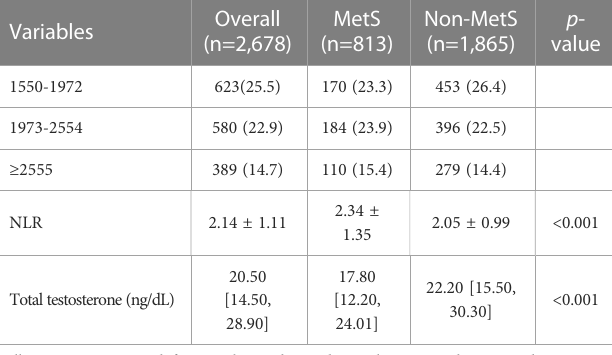
*All estimates accounted for sample weights and complex survey designs, and means and percentages were adjusted for survey weights of NHANES. MetS, metabolic syndrome; BMI, body mass index; NLR, neutrophil-to-lymphocyte